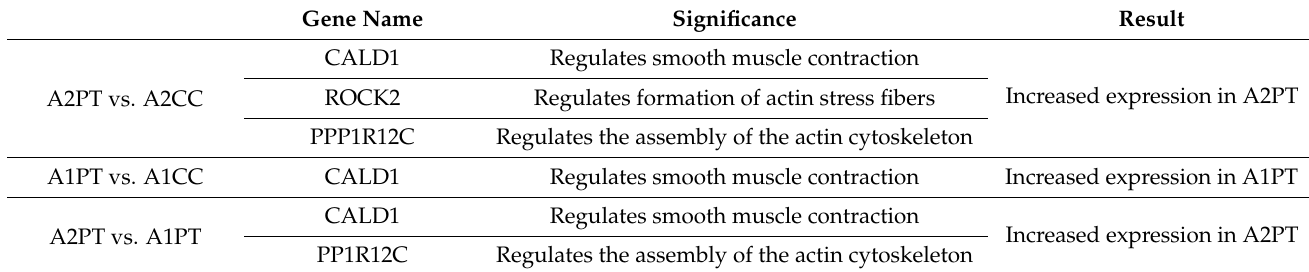
Table 4. RNA-Seq data analysis among different ADSC cell lines and treatments. A comparison between different treatments showing the presence of smooth muscle-specific circular RNA (Circ RNA) in PT treated samples compared to samples cultured in